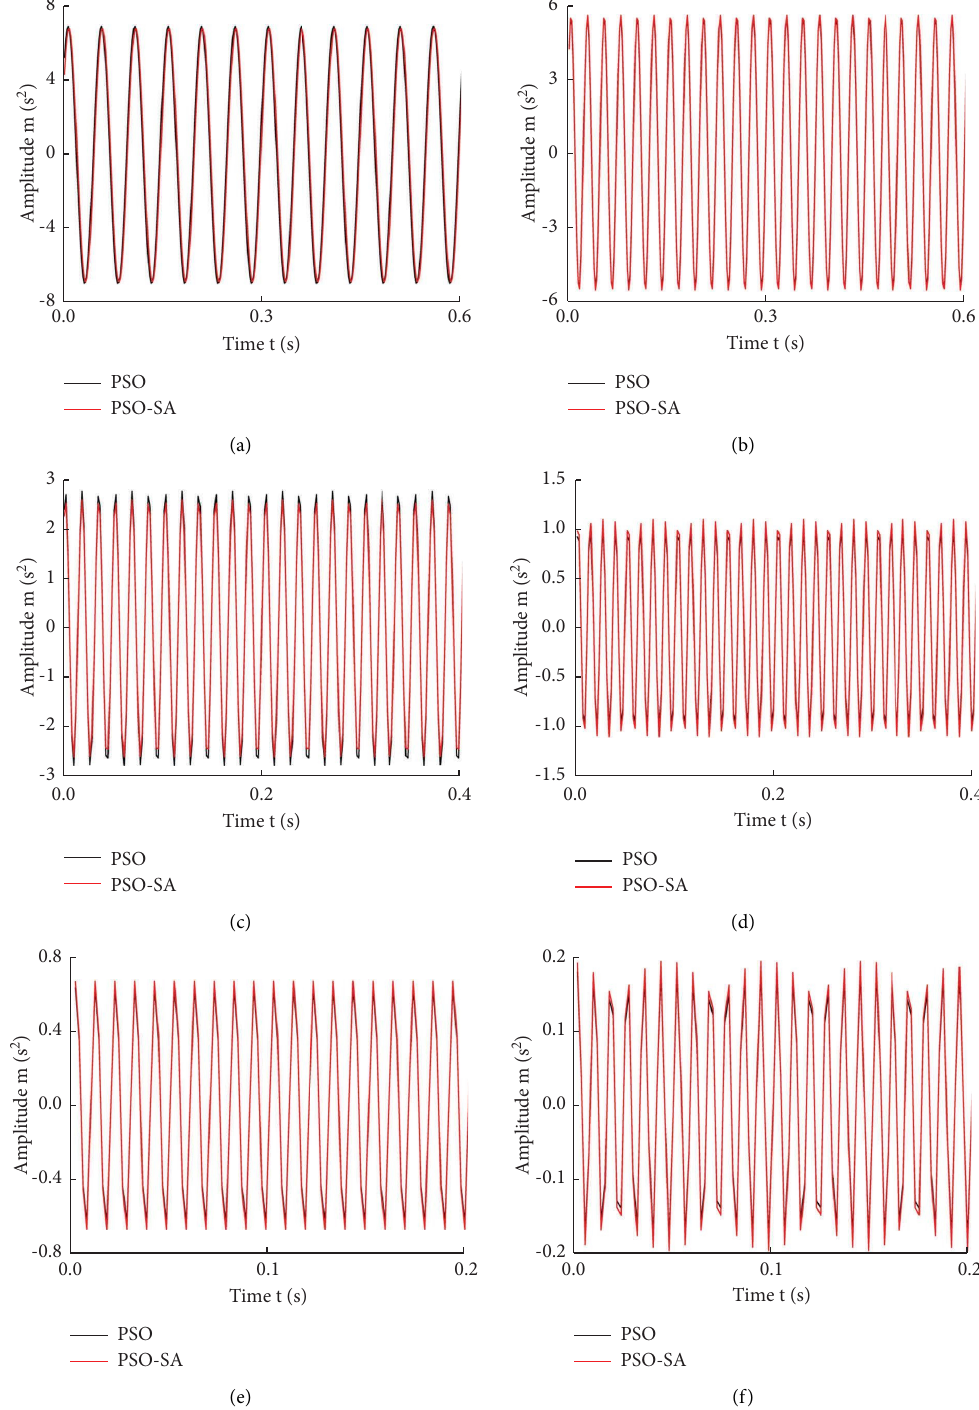
Figure 10: Waveform diagram of each order: (a) fundamental wave, (b) second harmonic, (c) third harmonic, (d) fourth harmonic, (e) ffth harmonic, and (f) sixth